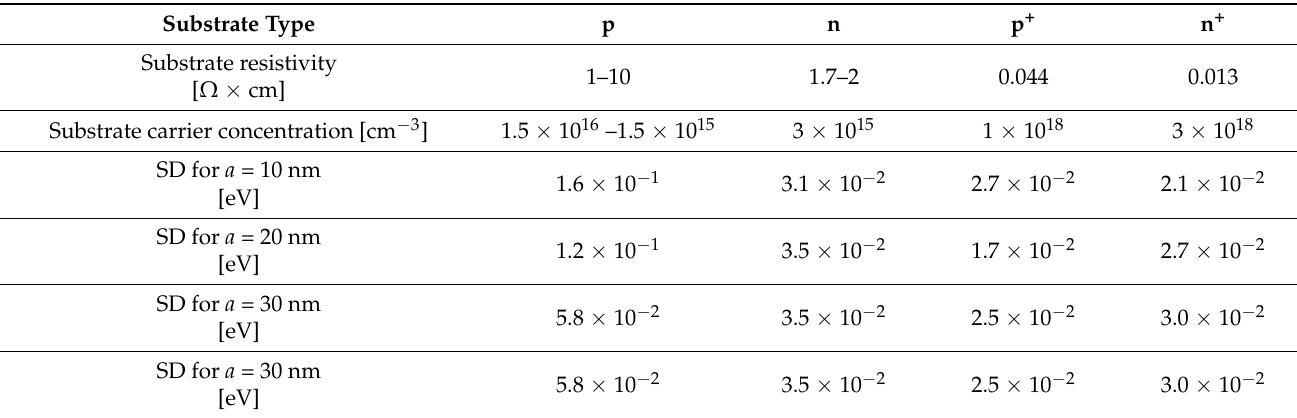
Table 1. Standard deviation (SD) dependence on the substrate type, doping level, and indent depth. Substrate resistivity and carrier concentrations are included for